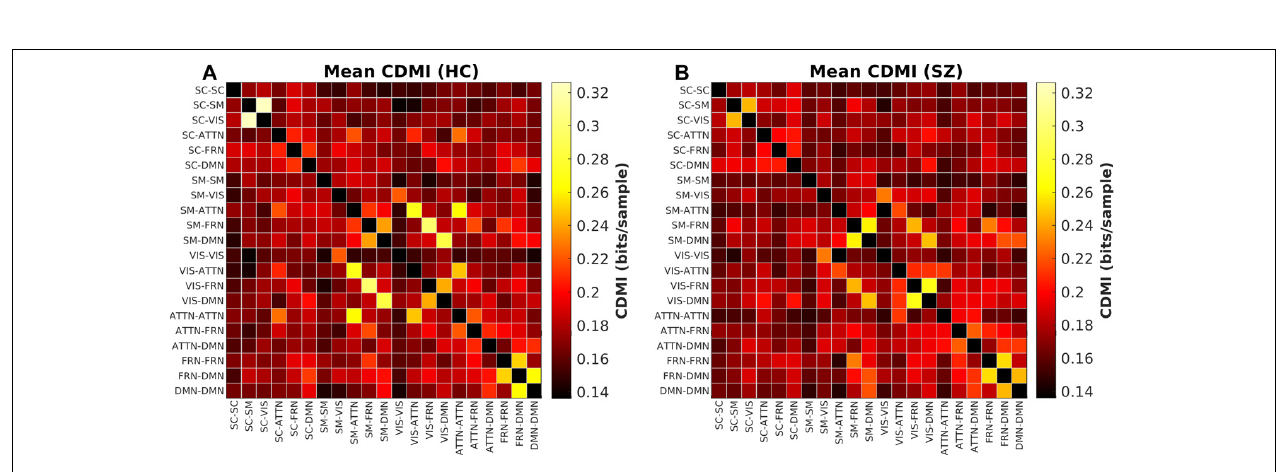
FIGURE 5 | (A) Mean CDMI between different DFDC for HCs, (B) for